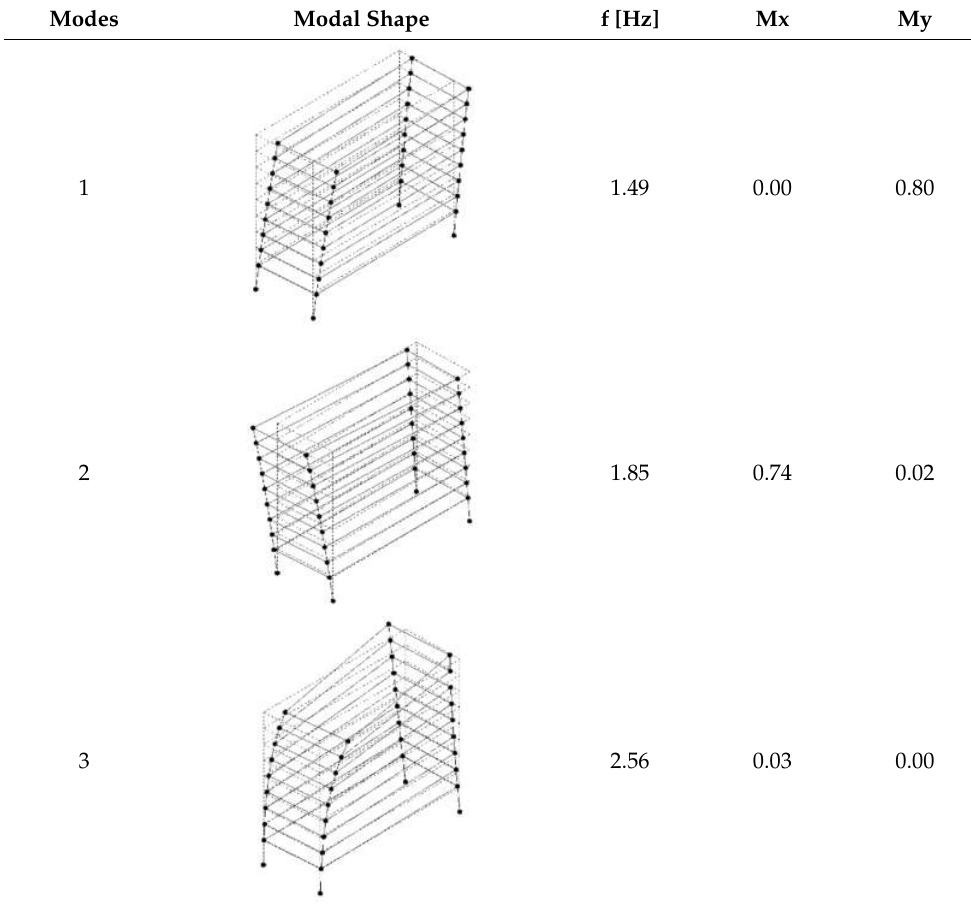
Table 7. Modal properties of the case study CS2.